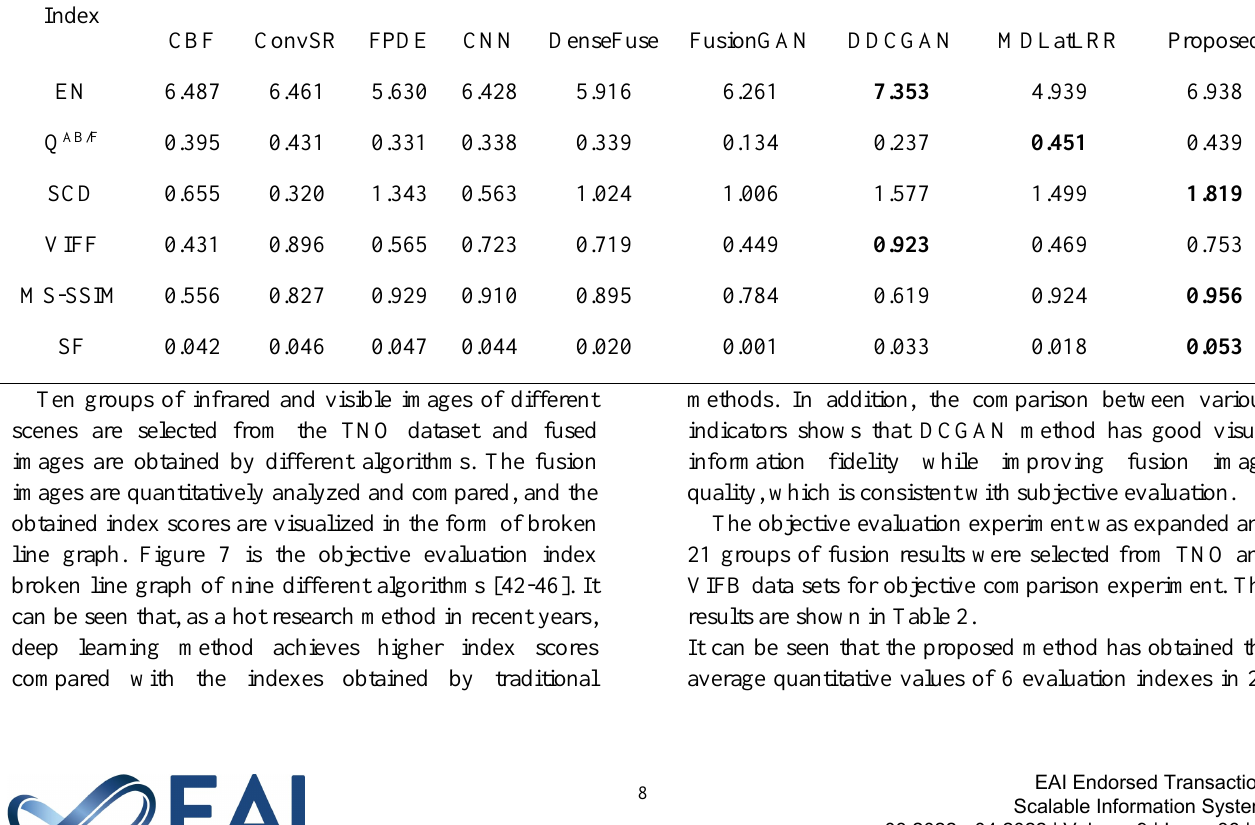
Table 1. ‘Two men in front of house’ objective evaluation of comparative experiments